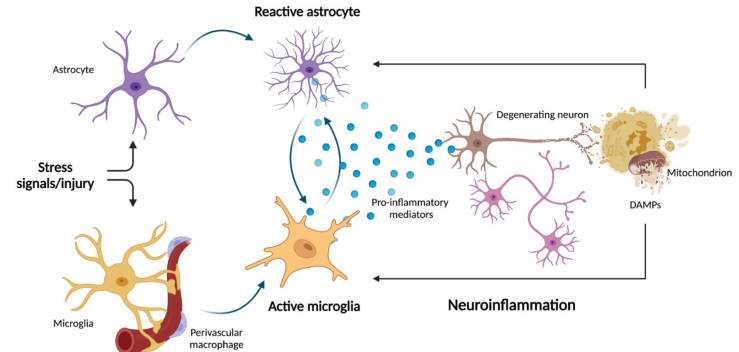
Figure 1. Schematic representation of microglia–astrocyte crosstalk during neuroinflammation and neurodegeneration. Following stress signals and injuries, aged glial cells and astrocytes may trigger astrogliosis. This process has been linked to crosstalk between mitochondrial dysfunction and neuroinflammation. The release of inflammatory mediators by activated glial cells can impinge on mitochondrial function, which in turn can promote further release of neuronal pro-inflammatory damage-associated molecular patterns (DAMPs). In this setting, mitochondrial DAMPs may have the dual role of mediating neurodegeneration and amplifying neuroinflammation. Created with BioRender.com, accessed on 12 May